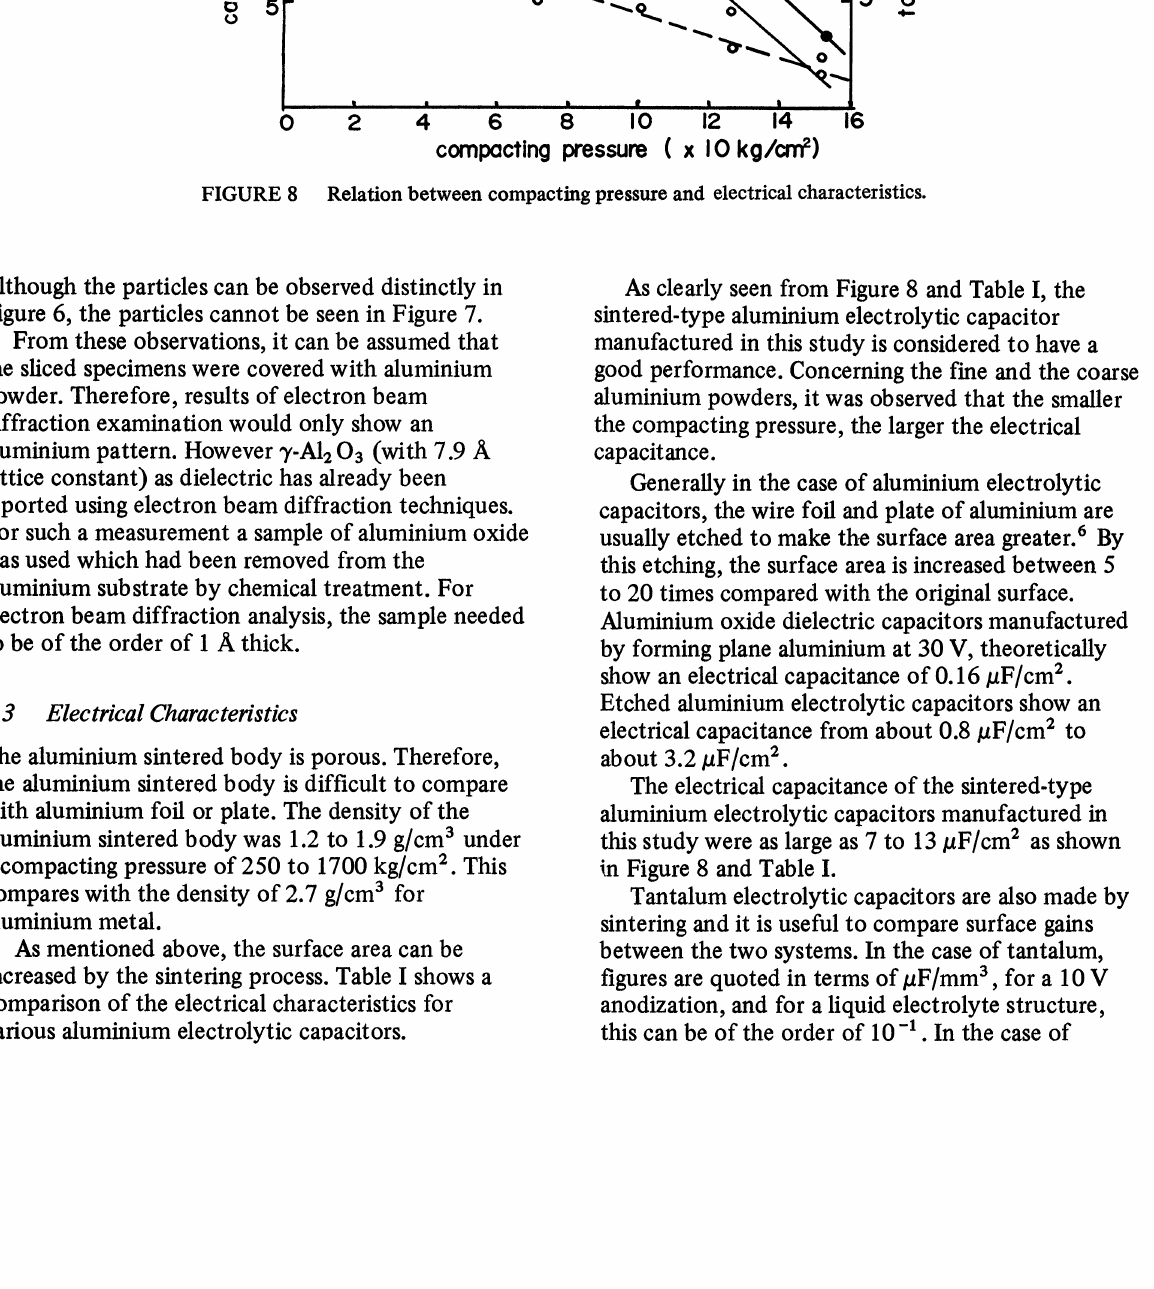
compacting pressure x I0 kg/cnq) Relation between compacting pressure and electrical